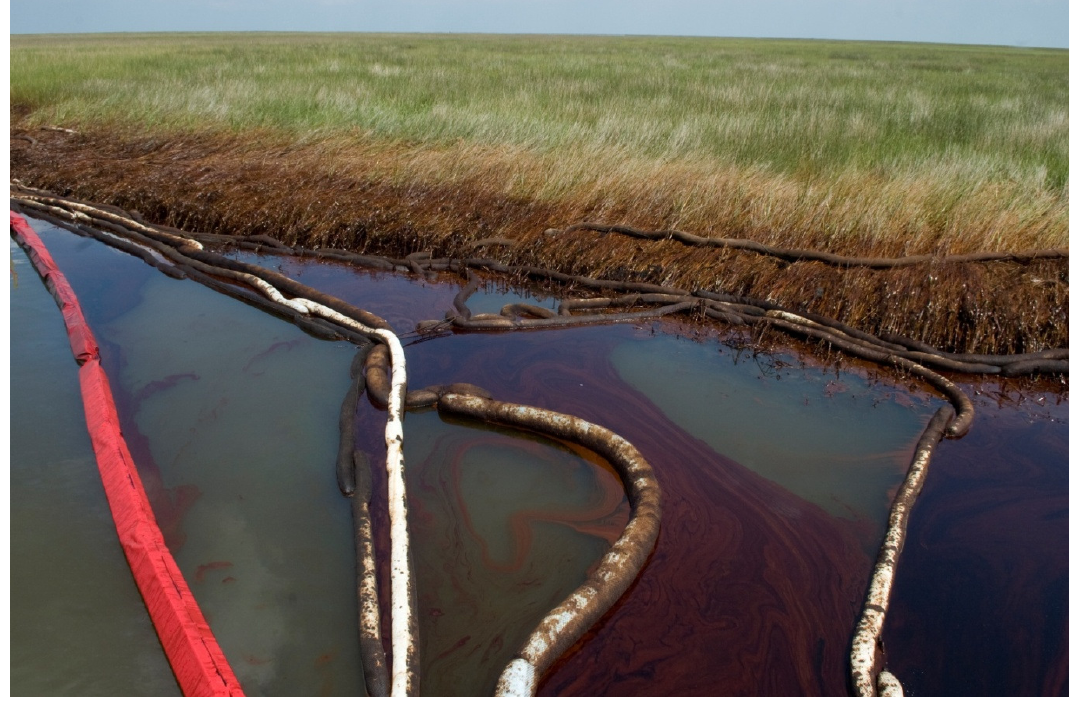
Figure 3. A photograph of the Deepwater Horizon oil spill and failed containment booms in coastal wetlands. Source: U.S. Coast Guard.